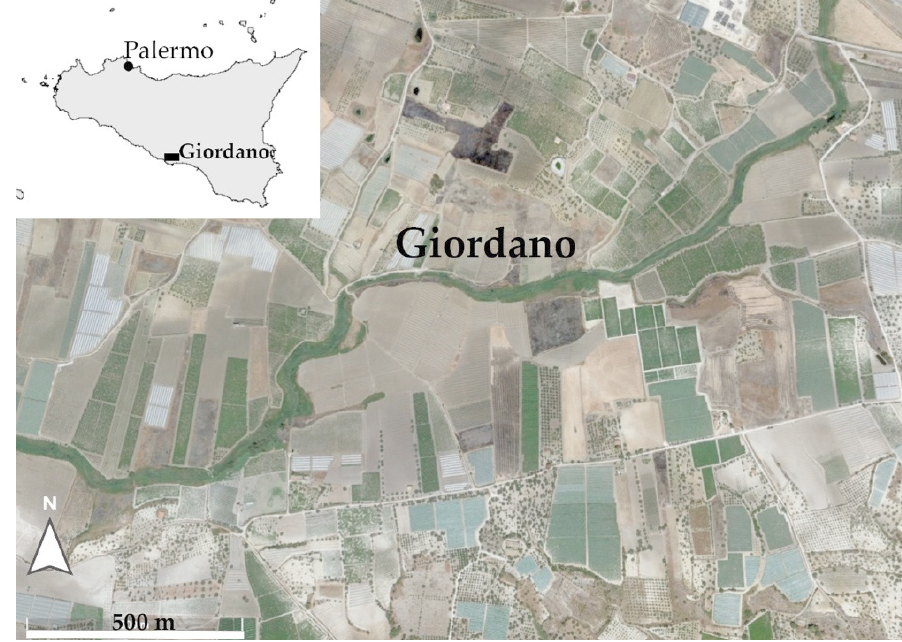
Figure 1. Location of the study area.